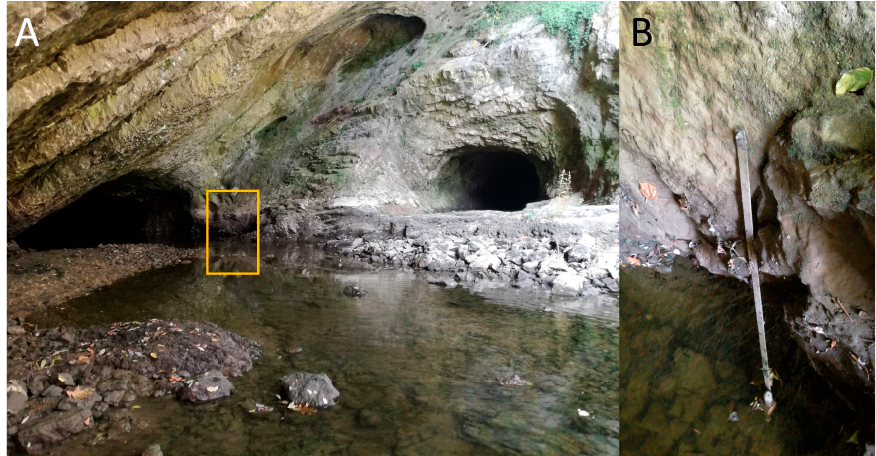
Figure 1. The Pivka River above its sink into Postojnska jama: ( A ) view of the ponor under extremely low water-level conditions, yellow box showing the designated position of the datalogger; ( B ) datalogger on site (4 October 2021).